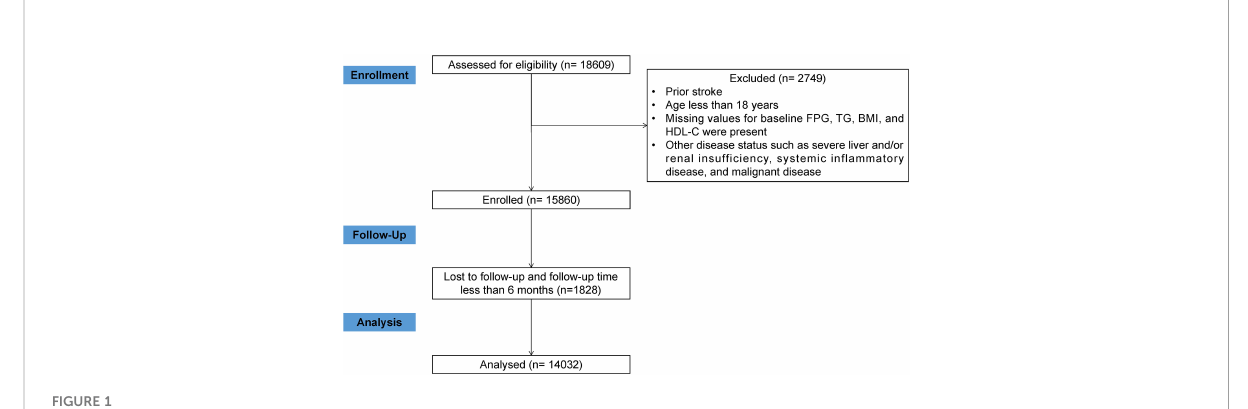
FIGURE 1 A study fl